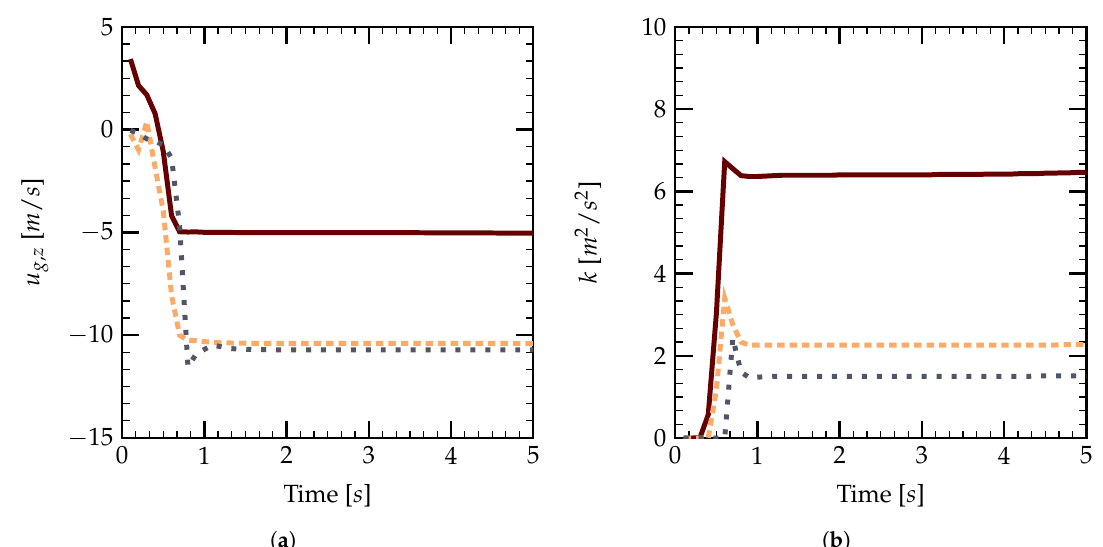
Figure 5. Time convergence of the axial gas velocity u g , z and the turbulent kinetic energy k (m 2 /s 2 ), with ∆ x = 1.5 cm, ∆ t = 1 ms: Position 1 ( h = 0.5 m) ( ), Position 2 ( h = 1.5 m) ( ), and Position 3 ( h = 2.3 m) ( ); ( a ) vertical gas velocity and ( b ) turbulent kinetic energy as a function of